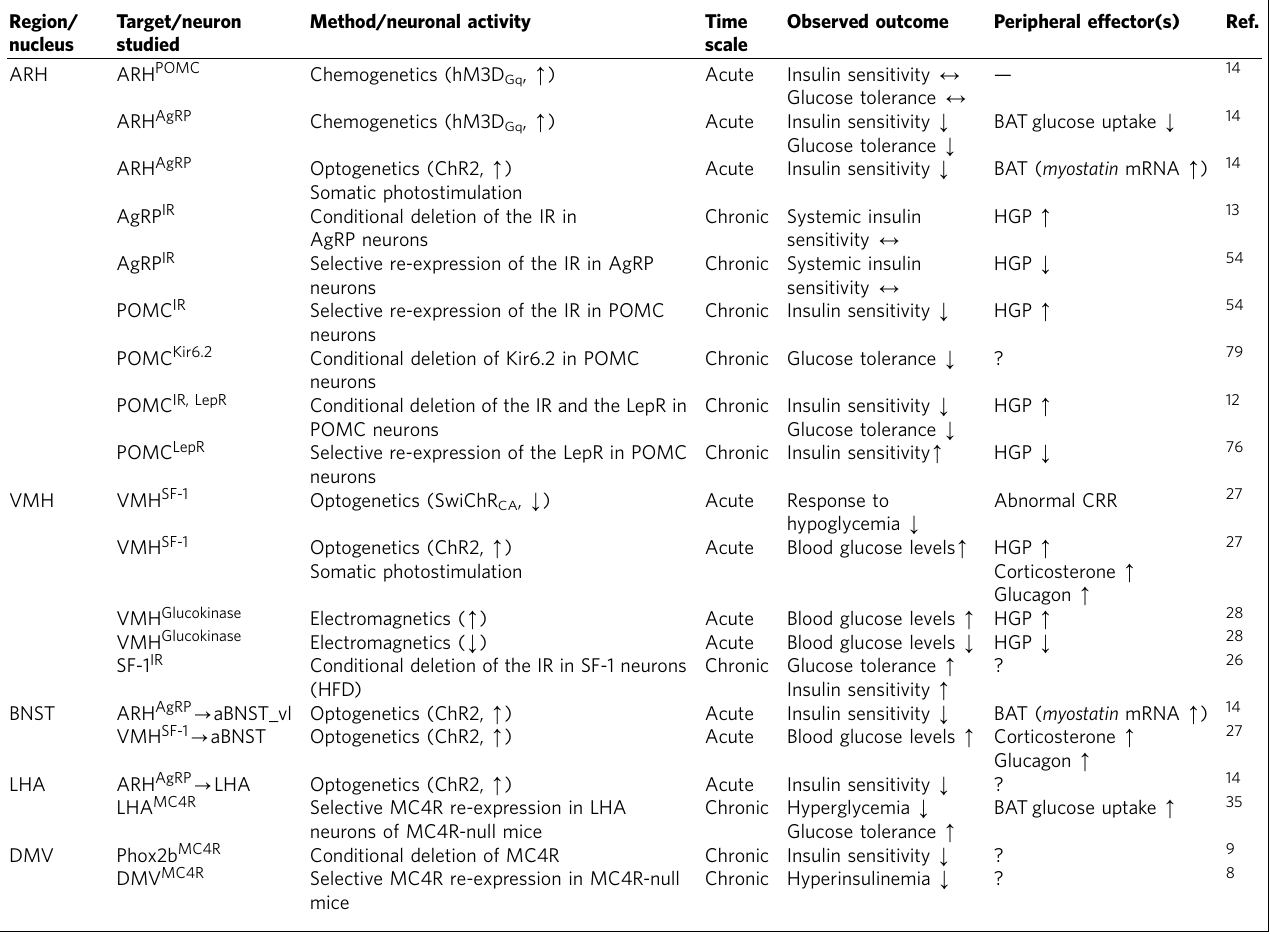
Table 1 | Cell type- and neurocircuit-specific manipulations reported to modulate peripheral insulin sensitivity and/or glucose homeostasis acutely or